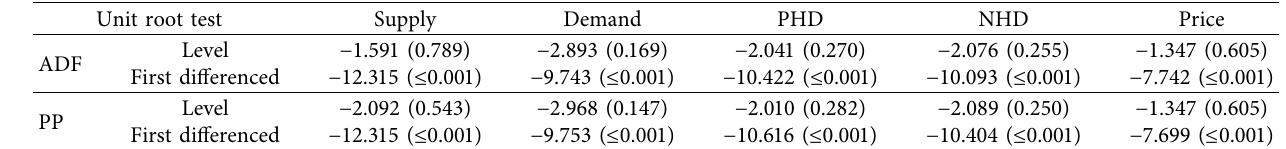
Table 4: Results of unit root test.